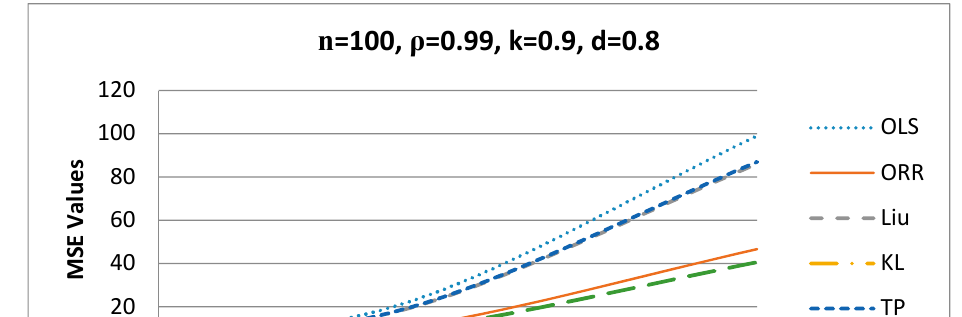
Figure 2. MSE values versus n values.